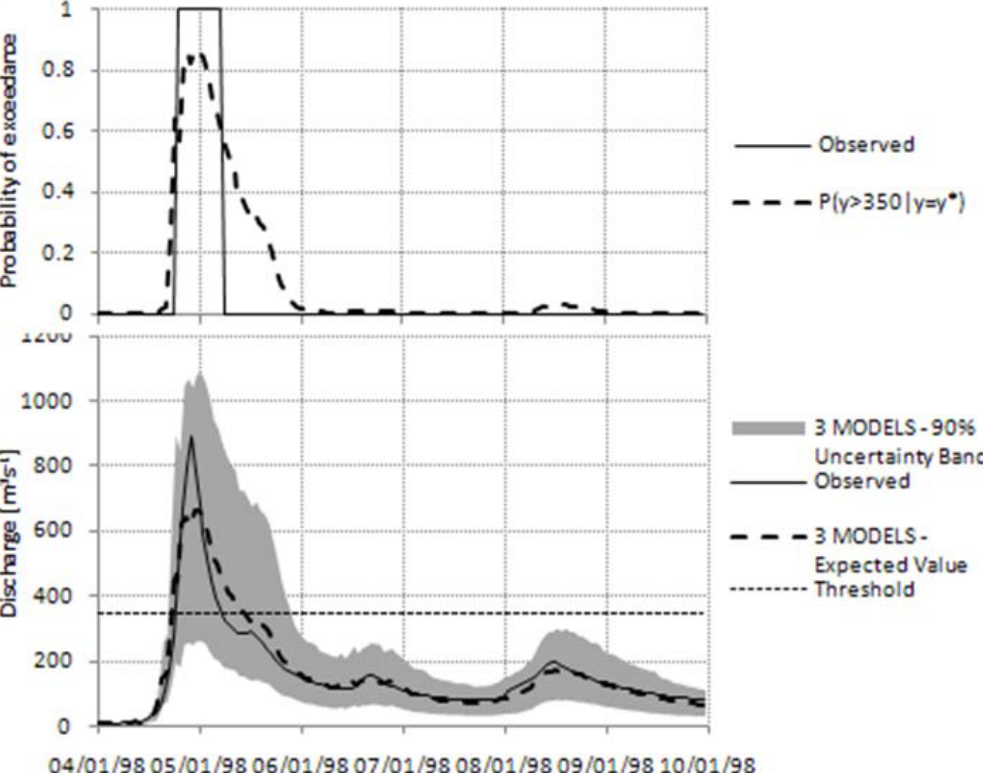
Fig. 18. Flood event for the validation period. The lower panel represents the discharge forecast; observed values (continuous line); ex- pected value conditioned to the TOPKAPI, TETIS and ANN forecasts (dashed line); 90% uncertainty band (grey area); alarm threshold of 350m 3 s − 1 (small dashed line). The upper panel represents the probability of exceeding the alarm threshold; observed binary response (continuous line) and Probability of exceeding the threshold computed by the MCP (dashed